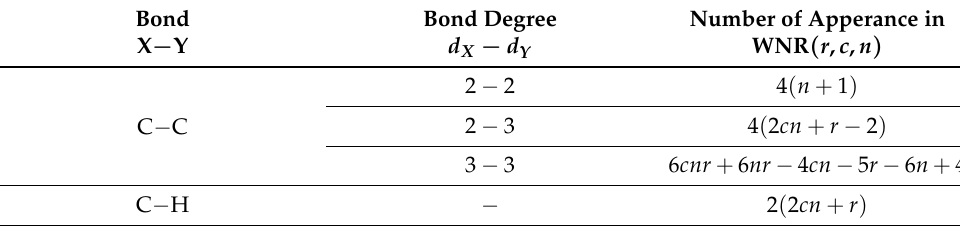
Table 3. Edge degree partition of wave-like